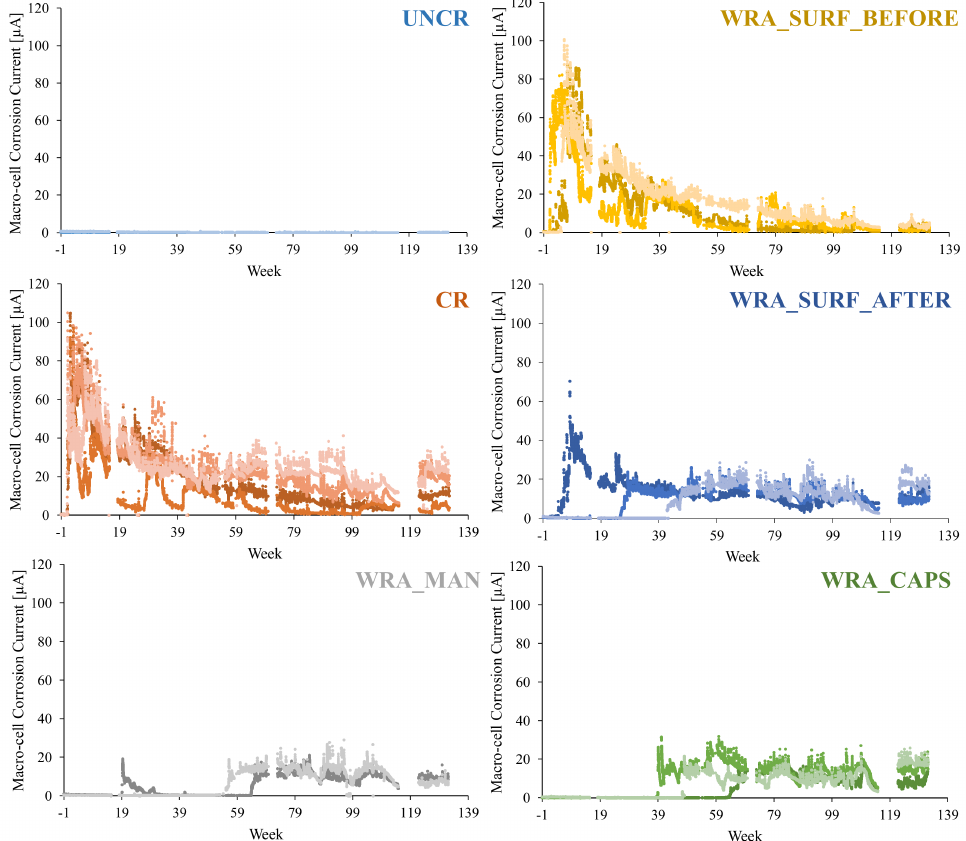
Figure 7. Macro-cell corrosion current measured for each of the different test series (result for one sample of the WRA_MAN series is missing as the internal electrical connection with the anode was damaged during concrete casting, different shades of the colours are used to represent the repetitions per test